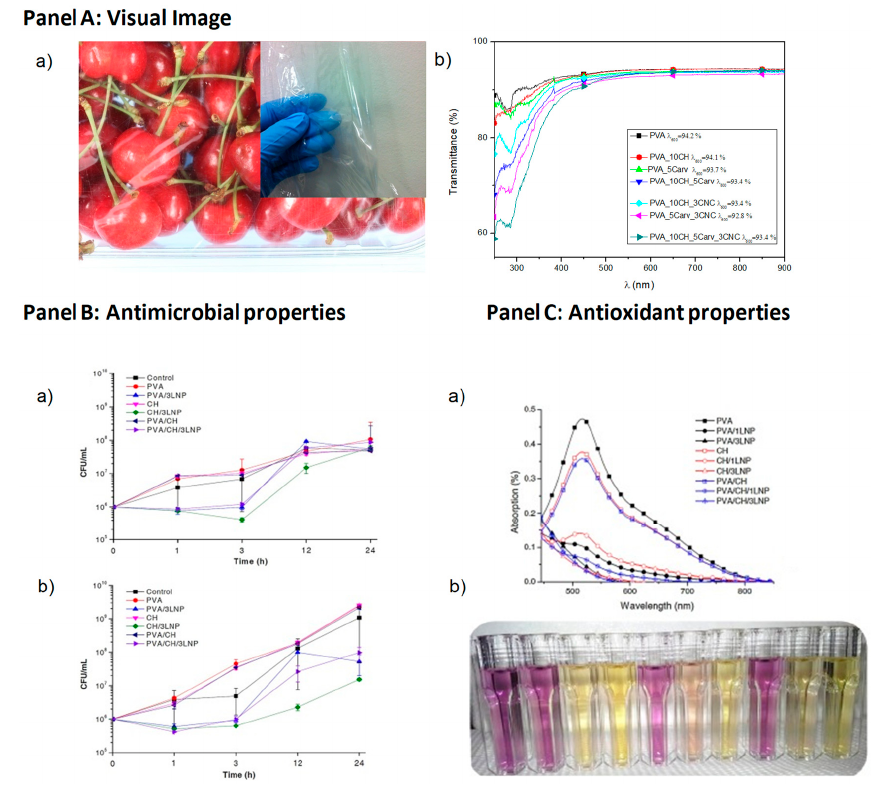
Figure 7. Panel A : Illustration of PVA/10CH/5Carv/3CNC formulation ( a ); and UV-Vis curves of PVA formulations ( b ) [286]. Panel B : Antibacterial study of PVA, PVA/CH, and PVA/CH/LNP nanocomposites, on the increase of plant pathogenic bacteria Pectobacterium carotovorum subsp. odoriferum (Pco) (CFBP 1115) 1 × 10 6 CFU/mL ( a ); and Xanthomonas arboricola pv. pruni (Xap) (CFBP 3894) 1 × 10 6 CFU/mL ( b ) [48]. Panel C : Antioxidant properties migrating substances of PVA/CH/LNP nanocomposites immersed in methanol solution for 24 h, measuring the absorbance level at 517 nm ( a ); and colorimetric deviation of the DPPH methanolic solution ( b )